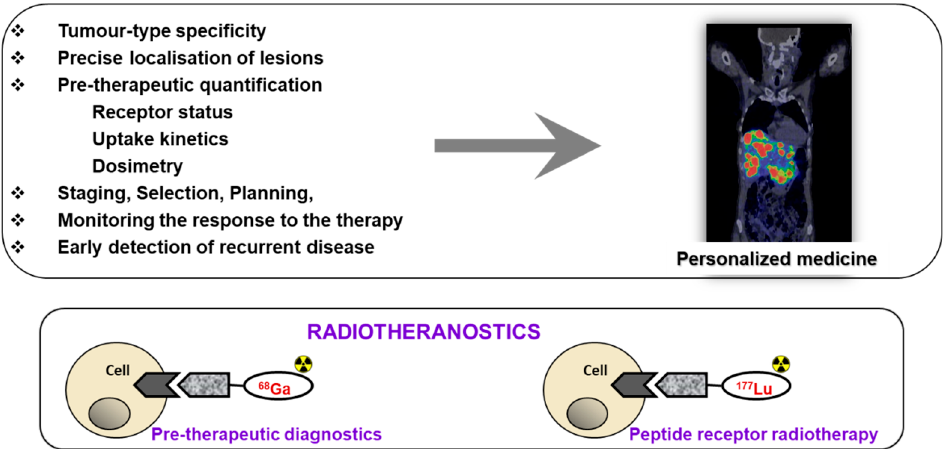
Figure 1. Upper panel: The targeted imaging in oncology provides tumor-type specific non-invasive diagnosis, precise localization of tumors and metastases that most importantly have the potential for pre-therapeutic quantification of receptor status, uptake kinetics and dosimetry that enables accurate therapy selection and planning, as well as monitoring response to the therapy resulting in personalized medicine. Lower panel: Some imaging and therapeutic radionuclides have similar coordination chemistry thus allowing for the radiotheranostic development wherein the pre-therapeutic imaging and radiotherapy are conducted with the same vector molecule exchanging the imaging and therapeutic radionuclides. Drawing presents the interaction of an agent, either imaging if labeled with, e.g., 68 Ga (left) or radiotherapeutic if labeled with 177 Lu (right), with the cell receptor. Reproduced from [8].